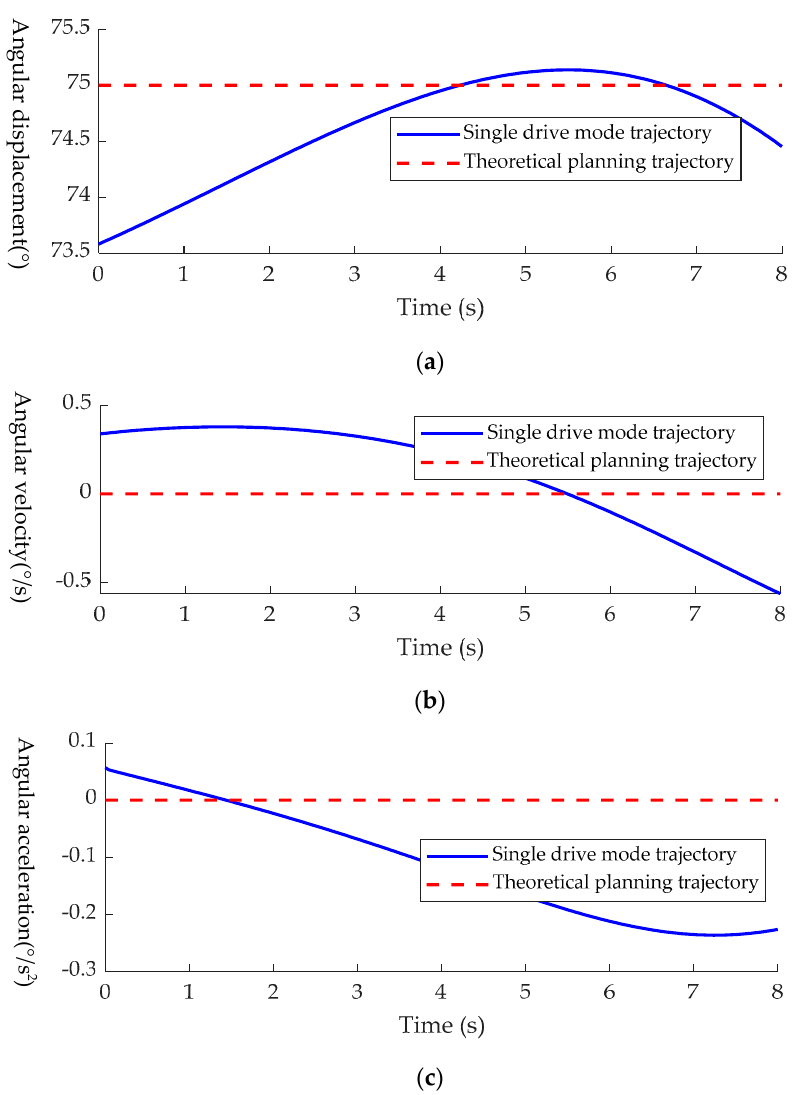
Figure 14. Comparison of kinematic performance between ideal mode and single driving mode: ( a ) comparison diagram of angular displacement; ( b ) comparison chart of angular velocity; ( c ) comparison diagram of angular acceleration.